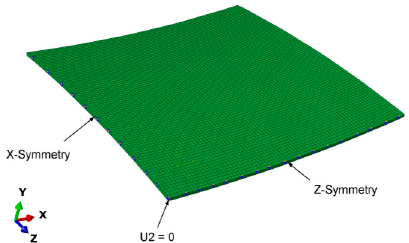
Figure 3. Simulation result before springback and the setup for implicit analysis.